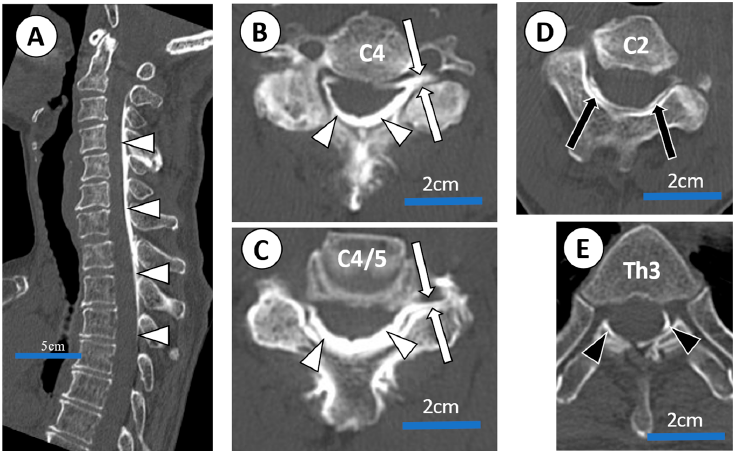
Figure 6. CT epidurogram after C4/5 US-guided epidural injection administered to a 73-year-old female with severe posterior cervical pain and right shoulder pain (case 4) associated with cervical canal stenosis. ( A ) Sagittal view of CT epidurogram. Dorsal spread (white arrow heads) between C2 and Th3 are confirmed. ( B , C ) Axial view of CT epidurogram (a slice of C4 vertebra and C4/5 disc; injection site). Dorsal spread (white arrow heads) and C5 root filling (white arrows) were confirmed. ( D , E ) Axial view of CT epidurogram at C2 and Th3 vertebra ). Cephalad spread (black arrows) was